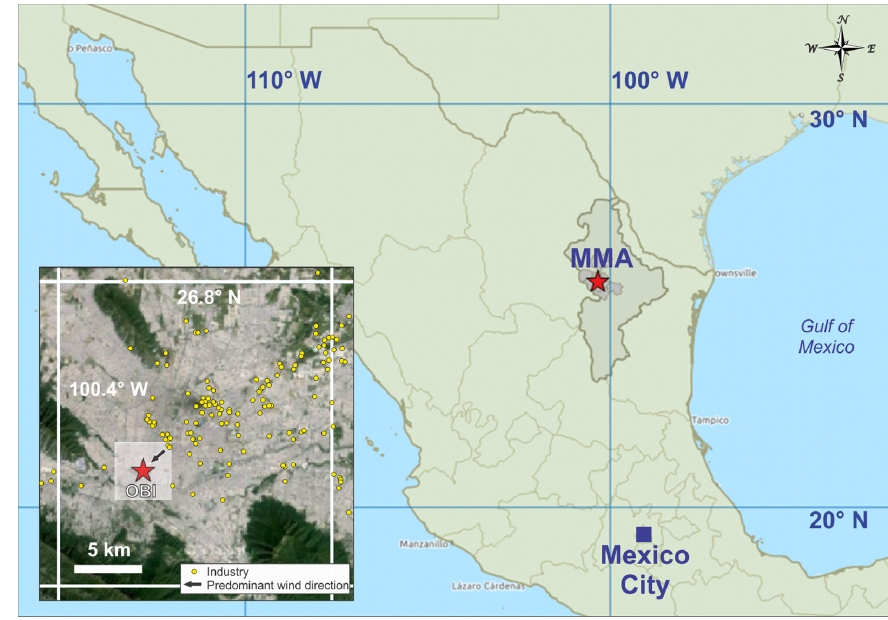
Figure 1. The Monterrey Metropolitan Area (MMA) in the national context in northeast Mexico and the location of the Obispado (OBI) site within the MMA. The shadowed white square surrounding the OBI site represents the 4 km × 4 km domain used for modeling purposes.